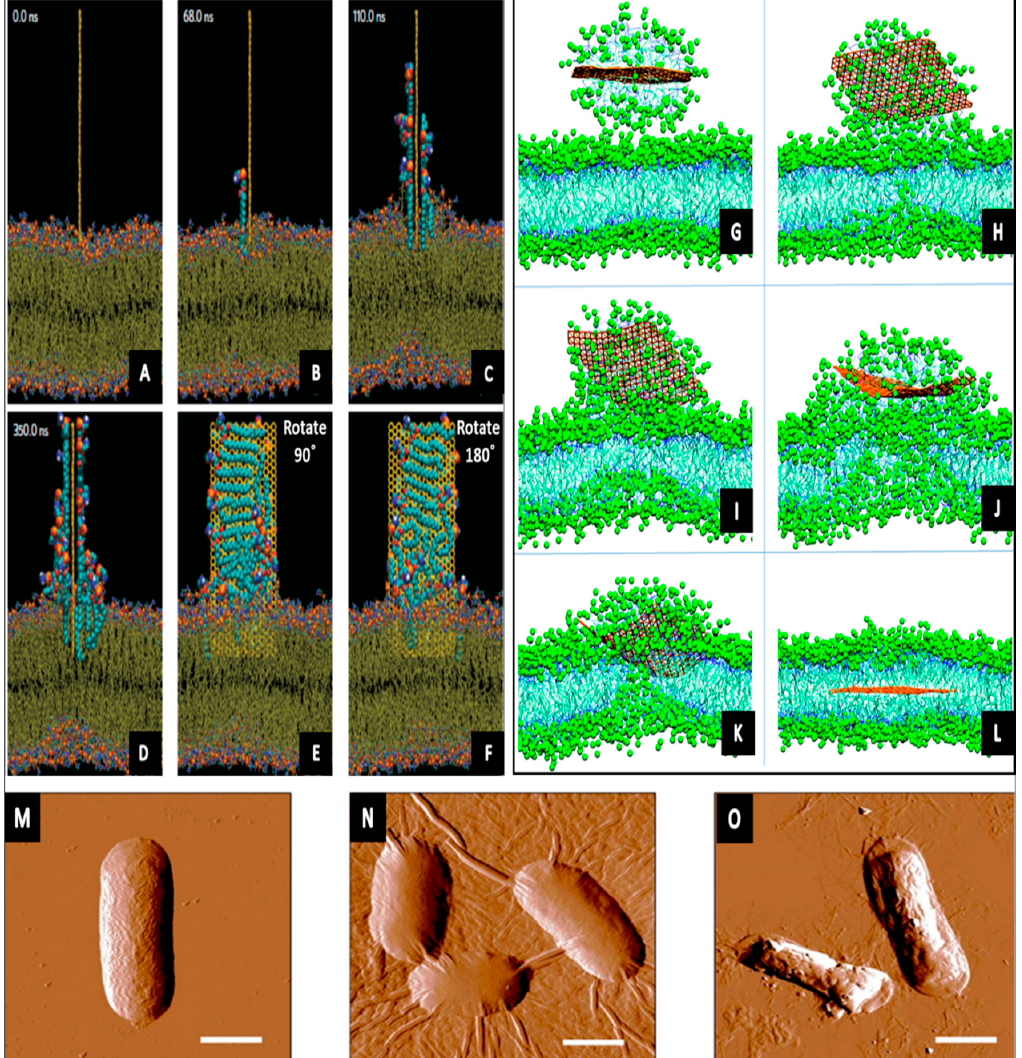
Figure 4. Simulation 1 ( A – F ) shows lipid extraction by a graphene nanosheet. An illustrative route of a fully restrained graphene docked at the surface of the outer membrane. The simulation time is shown in each snapshot; e and f are rotated counterclockwise by angle (90° and 180°) from its previous view. Reprinted with permission from Reference [37]; simulation 2 ( G – L ) describes the process of self-insertion of graphene sheet into the phospholipid membrane. A graphene sheet merges with the membrane and releases the monolayer that enters the membrane. The snaps are taken at t G – L = 2.9, 52.4, 120.0, 299.2, 356.4, and 516.4 ns, respectively. Reprinted with permission from Reference [120]; representative AFM images showing E. coli cells after incubation with: ( M ) deionized water without GO for 2 h; ( N ) 40 μ g/mL GO-0 suspension for 2 h, and ( O ) the 40 μ g/mL GO-240 suspension for 2 h. These images reveal the lateral dimension-dependent antibacterial performance of GO nanosheets. Larger GO sheets are covering most of the bacterial cell surface during the interaction compared to smaller nanosheets. The scale bars are 1 µ m for all images. Reprinted with permission from Reference